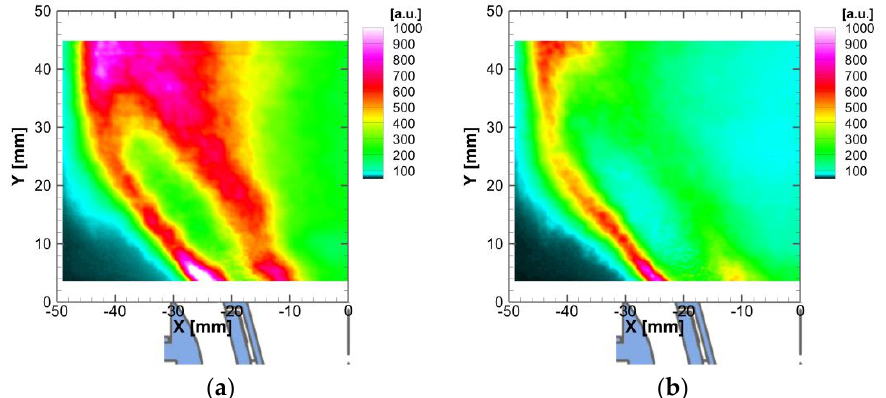
Figure 14. OH-LIF distribution under idle conditions: ( a ) case P and ( b ) case M. (Illustration of the burner exit section is superimposed beneath the horizontal axis).